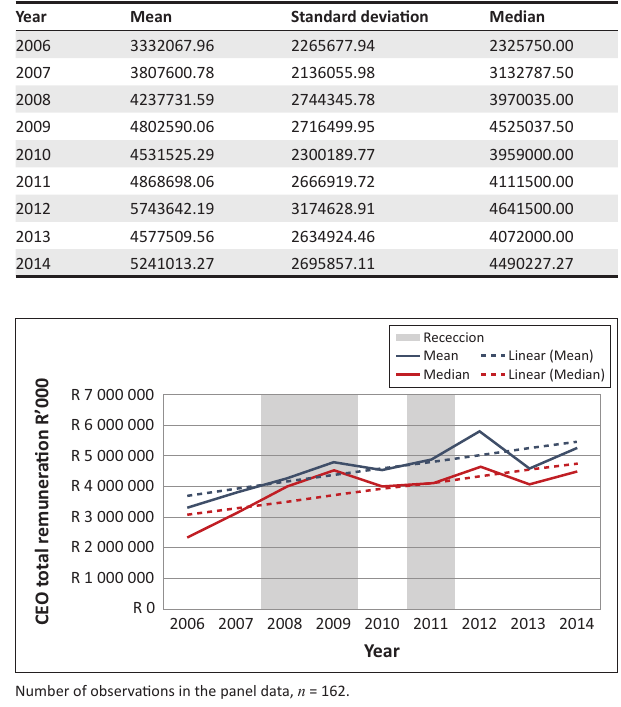
FIGURE 2: Graphical presentation of the descriptive statistics for chief executive officer total remuneration